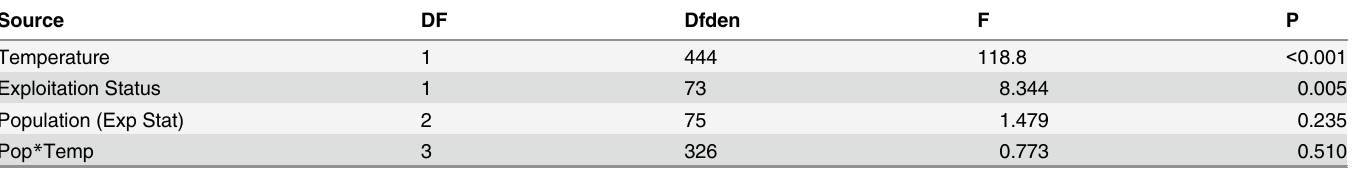
Table 1. Mixed Model ANCOVA Table.